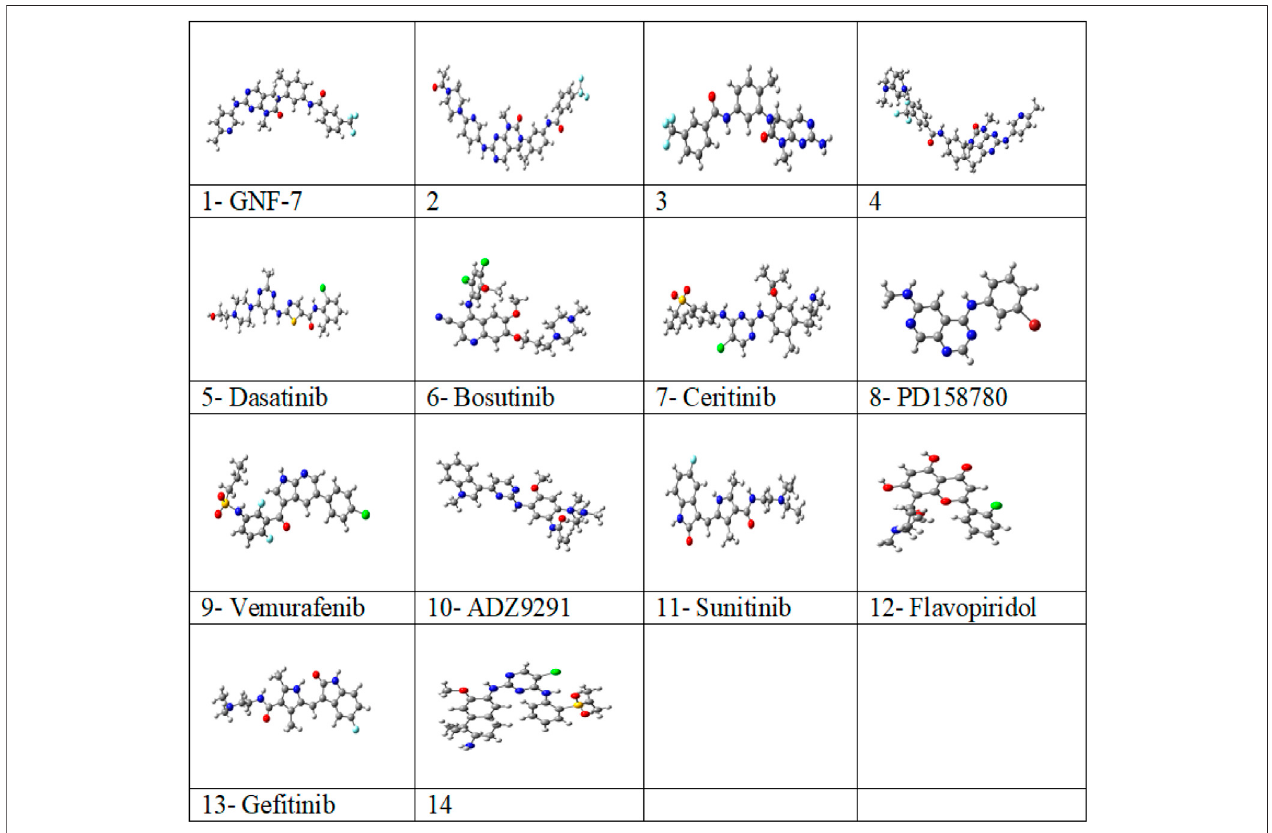
FIGURE 1 | Optimized structures of studied 14 multikinase inhibitors with M06-2X/6-31G (d, p) in solvent (water) from the G16 software program.